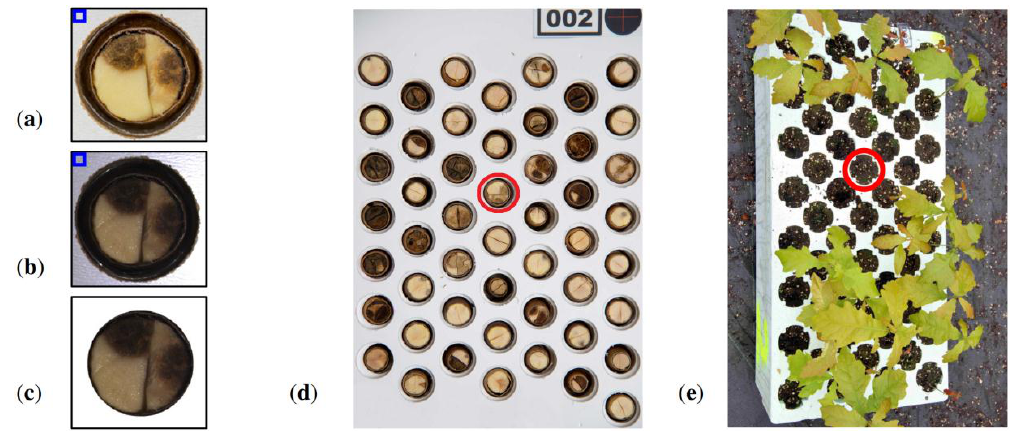
Figure 1. Images of scarified acorn Id. = 75 acquired during the experiment: ( a ) captured by high resolution camera; ( b ) captured by machine vision camera; ( c ) segmented section used in computer analysis; ( d ) cassette number 2 containing 50 scarified acorns; ( e ) germination status in container number 2. Legend: Id. —identifier of subsequent acorn processed during the experiment, blue